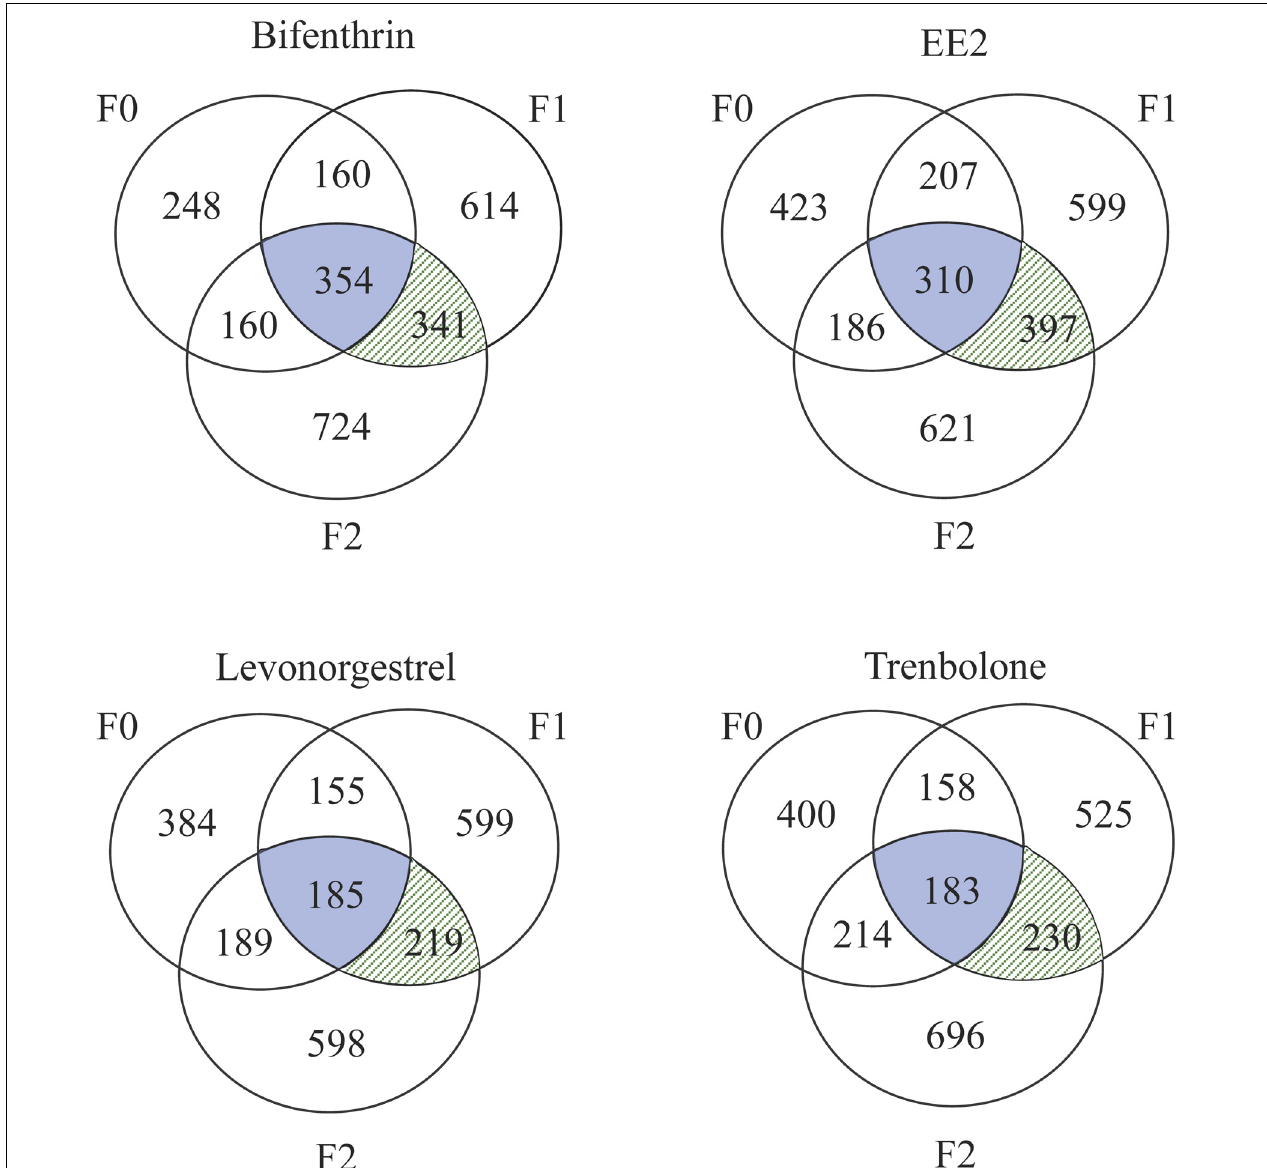
FIGURE 2 | Venn diagrams showing the number of genes (promoter and gene body regions combined) displaying differential methylation relative to control by treatment and generation as informed by the M. beryllina transcriptome. F0 animals were treated with an EDC (Bif, EE2, Levo, or Tren) during early development. F1 animals were exposed to these treatments indirectly as primordial germ cells within the F0 animals, and F2 animals were not exposed at all. The differential methylation in F1 animals is indicative of a multigenerational effect of EDCs, while the differential methylation in the F2 generation indicates a transgenerational effect. Differentially methylated genes shared by F1 and F2 (shaded green stripes), sometimes originating in F0 generations (shaded blue), is indicative of potential transgenerational epigenetic